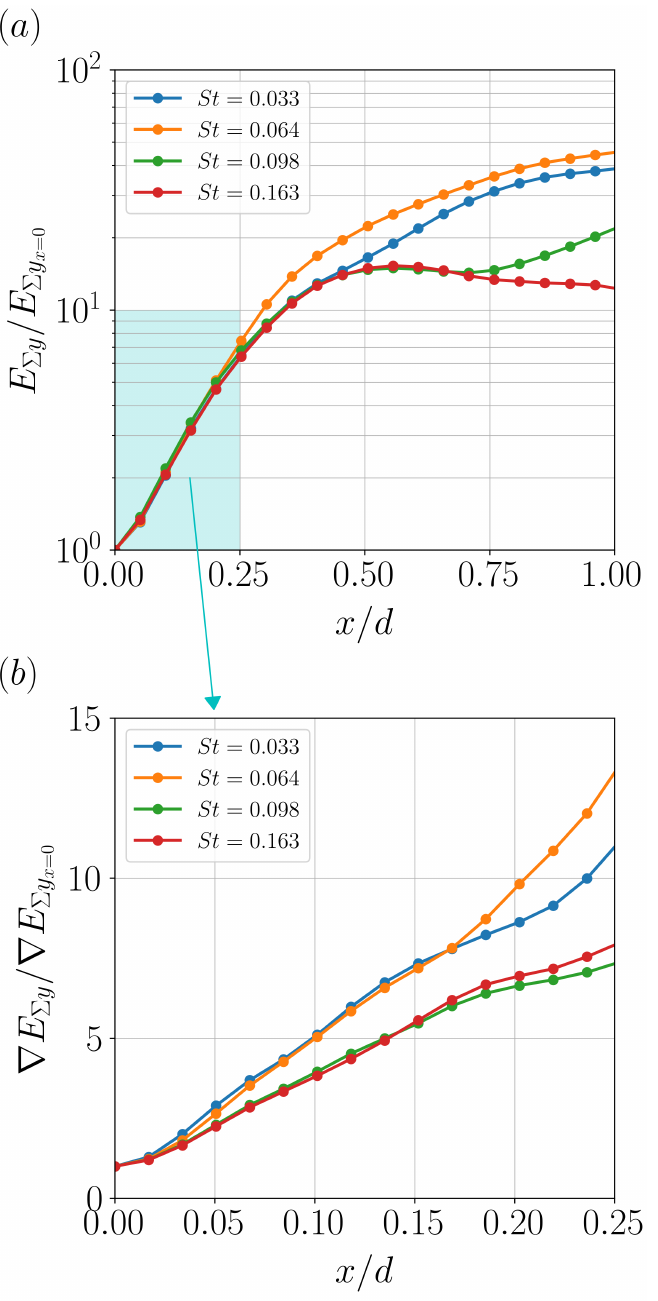
Figure 11. Streamwise variation of the DMD mode energies: ( a ) energies in the near-field region of the jet; ( b ) gradient of the energies in the cyan highlighted